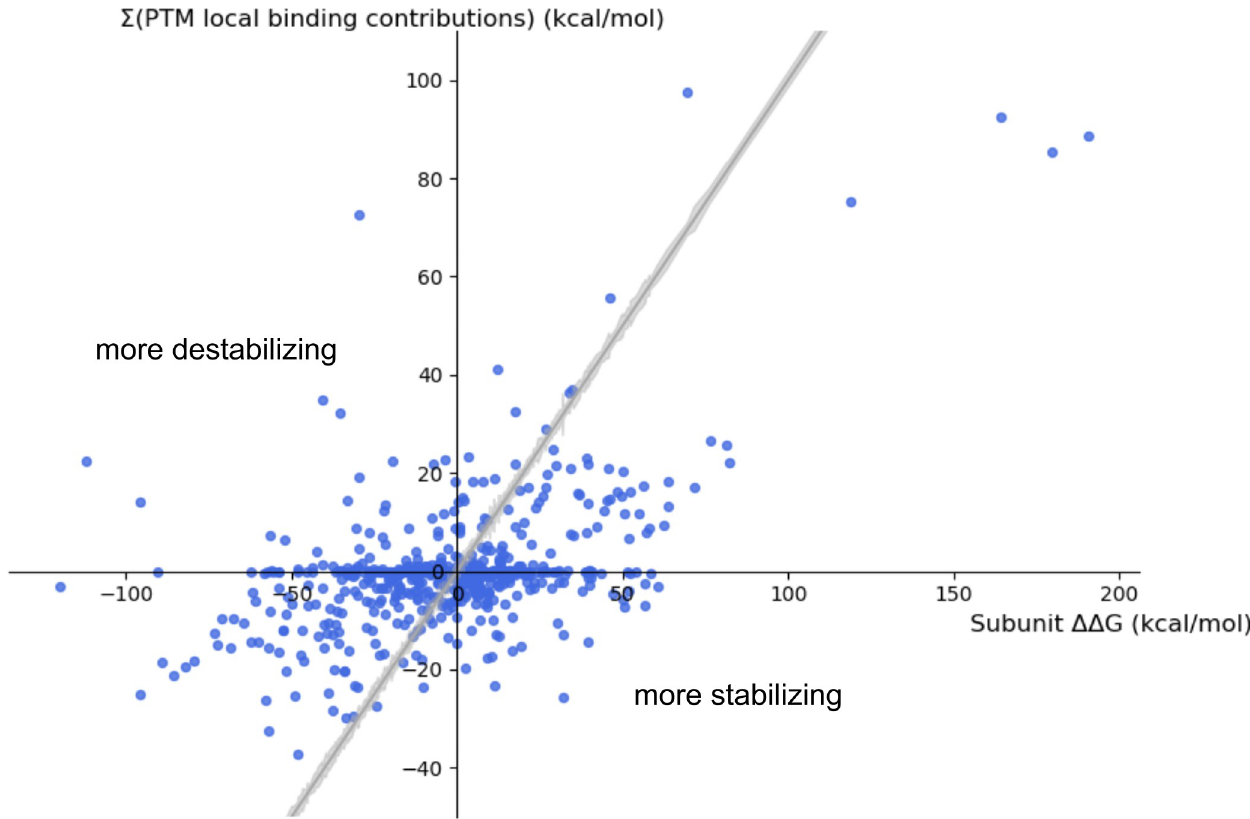
Fig 3. Correlation between the subunit ΔΔ G bind values and the sum of ΔΔ G bind,contribution of PTMs located in the respective protein chains. Points above the grey line ( y = x , with the surrounding grey area describing the error in subunit ΔΔ G bind values) belong to systems in which the overall effect of PTMs on subunits’ binding is more destabilizing than could be expected based solely on local contributions of the PTMs, and the other way around for points below the grey line, both thanks to long-range effects. For systems described by points lying within the grey area, the local effect of PTMs does explain the overall effect on